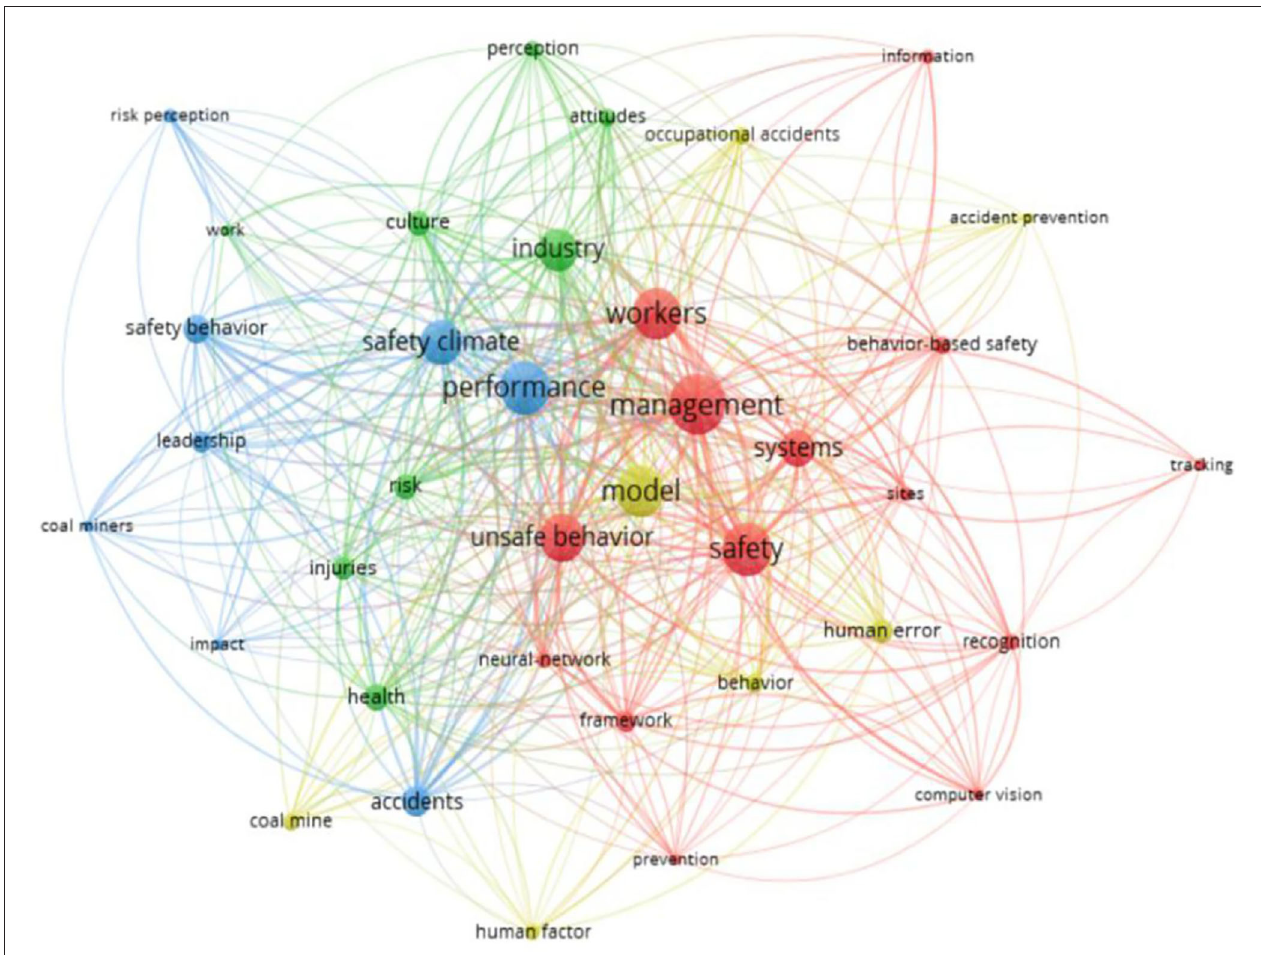
FIGURE 4 | The cluster graph of keyword co-word